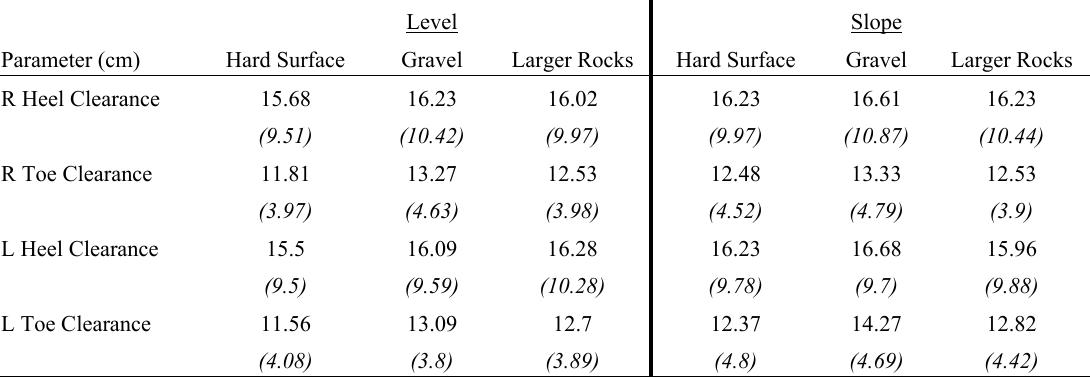
Table 2. A summary of mean toe and heel clearances by slope for all surface types. Note: Mean (s.d.)